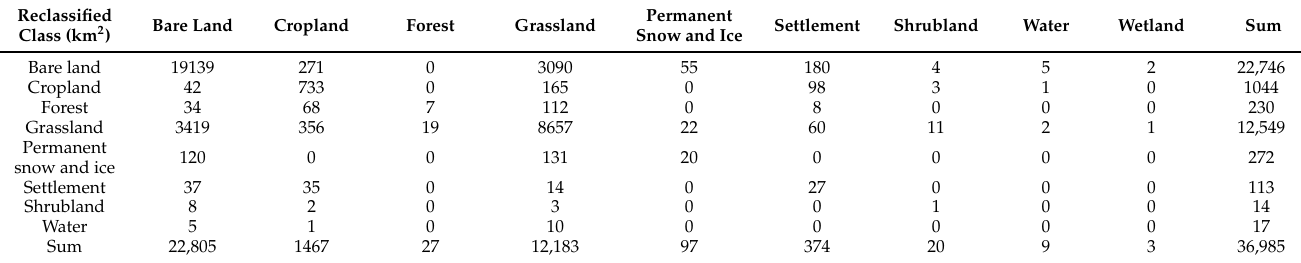
Table 4. The land use/land cover area transfer matrix from 1980 to 2020 in the Turpan